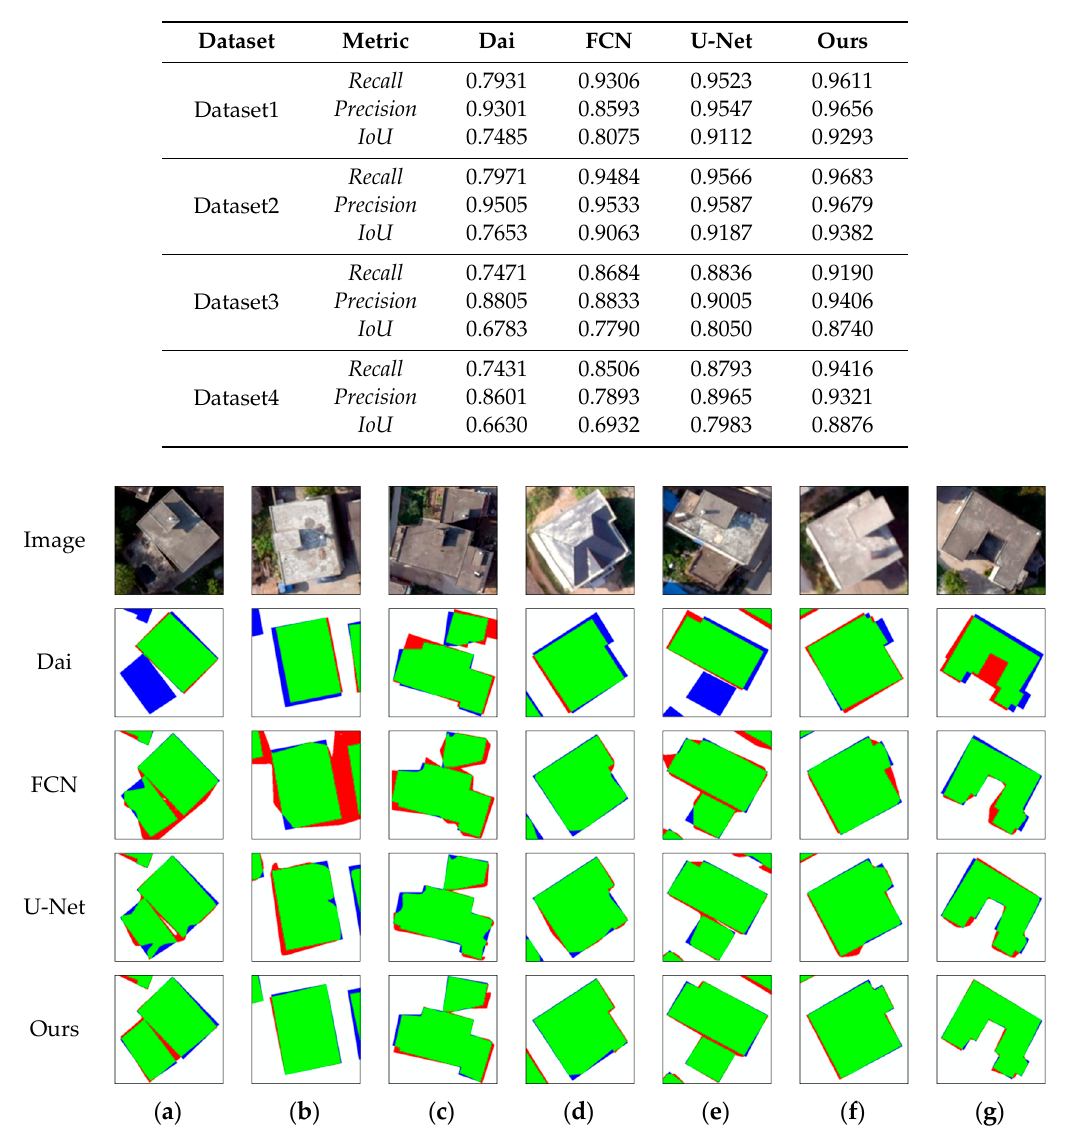
Figure 20. Representative results of single-building-level building extraction from Dai’s method, FCN, U-Net, and our method. ( a – g ) are the seven examples that are selected to exhibit the experimental results. The green, red, blue, and white channels in the results respectively represent the TP, FP, FN, and TN of building areas.